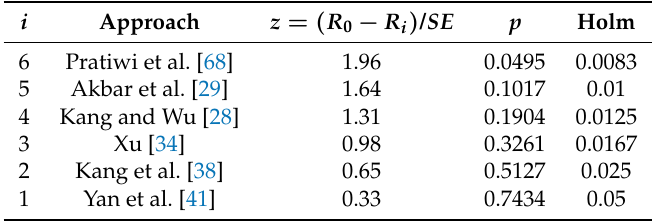
Table 11. Approaches sorted by p -value and adjusting of α resulting from Holm procedure at α = 0.05.